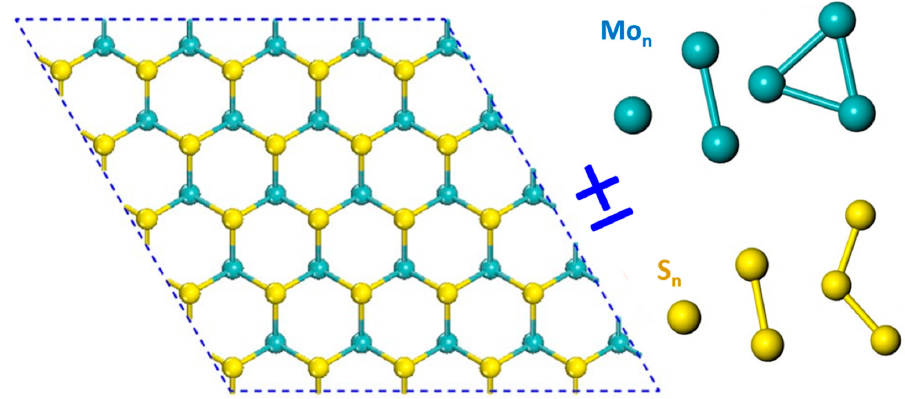
Figure 2. The adsorption and desorption strategy uses the compositional elements as the dopants or deficits.